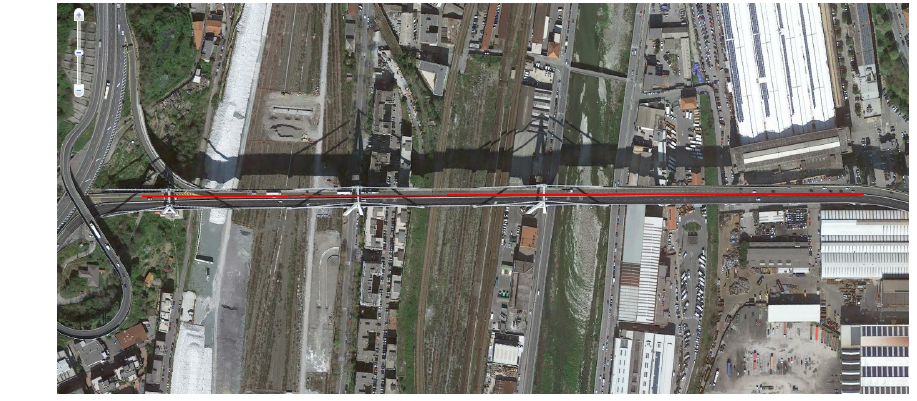
Figure 32. “Morandi” bridge. Satellite image.